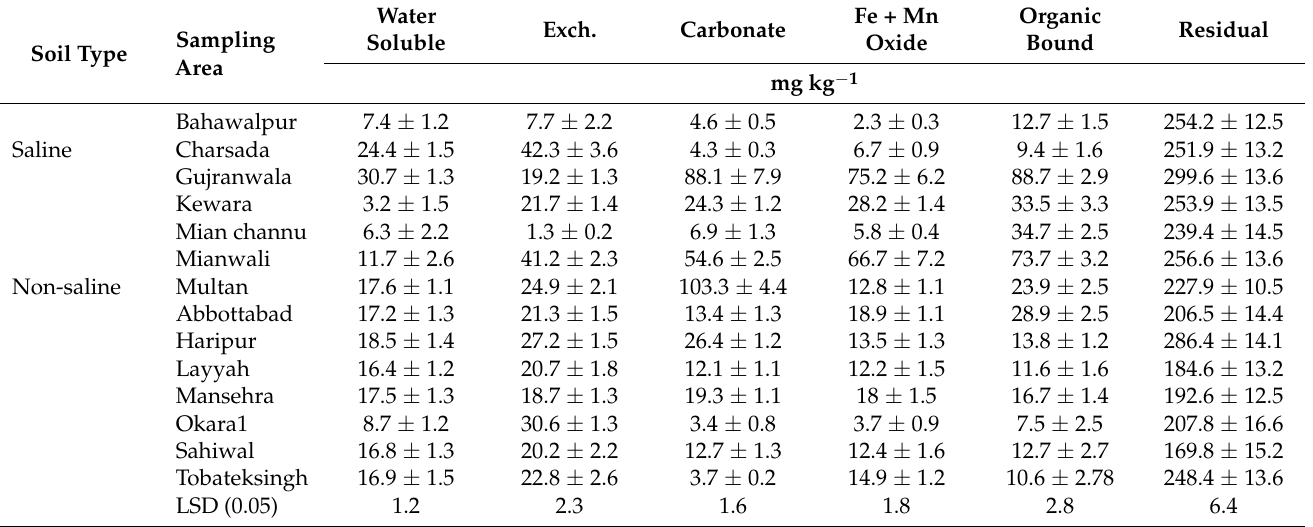
Table 5. Fractionation of Mn in saline and non-saline